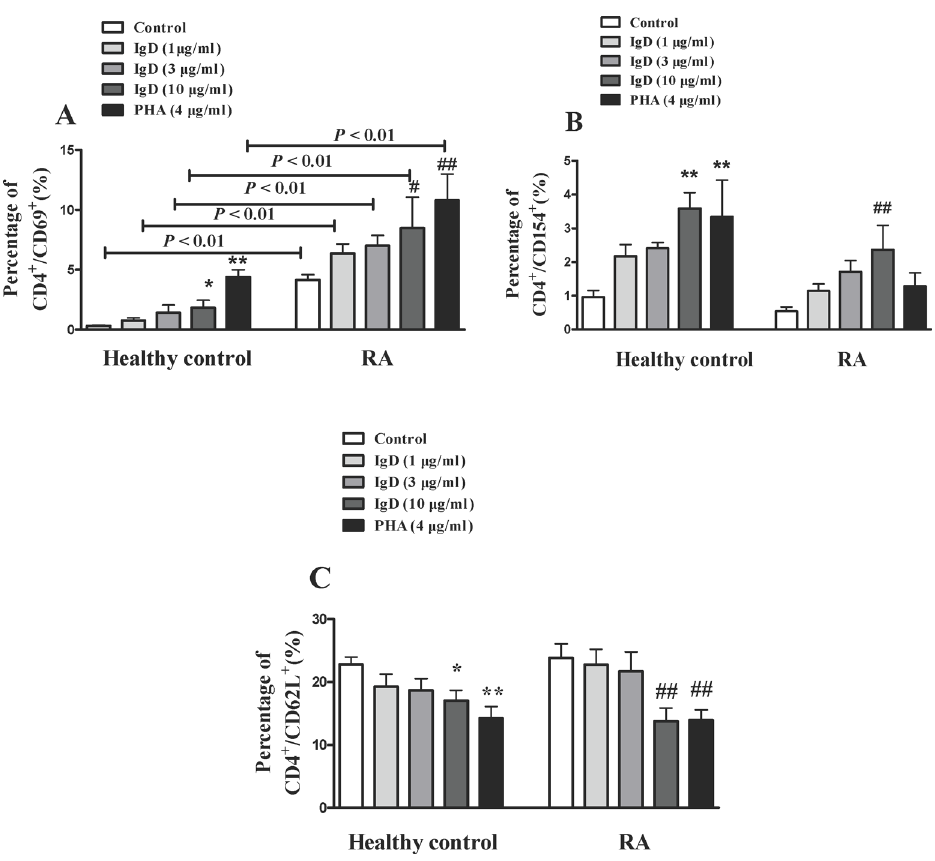
Fig 6. The effects of IgD on subsets of T cells in PBMCs from RA patients and healthy controls. Flow cytometry analysis was used to analyze the effects of IgD (1, 3, or 10 μ g/ml) or PHA (4 μ g/ml) on activated T cells (CD4 + CD69 + , CD4 + CD154 + ) and unactivated T cells (CD4 + CD62L + ). Data are expressed as the mean ± standard error of the mean (n = 8). * P < 0.05, ** P < 0.01 vs . the control from healthy controls; # P < 0.05, ## P < 0.01 vs . the control from RA.